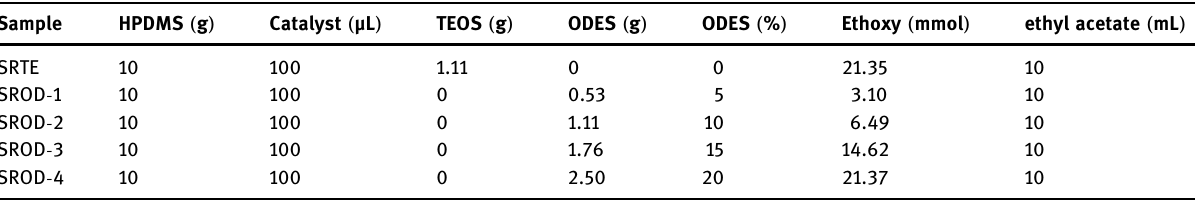
Table 1: Components of RTV silicone rubber